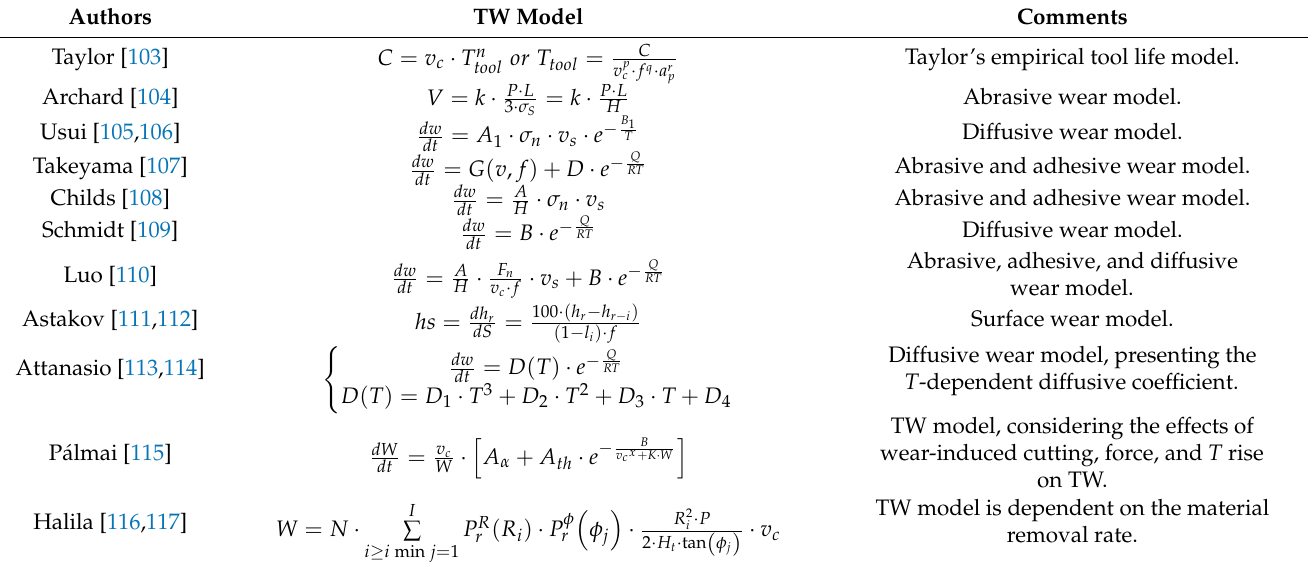
Table 10. Typical TW mathematical models (adapted from